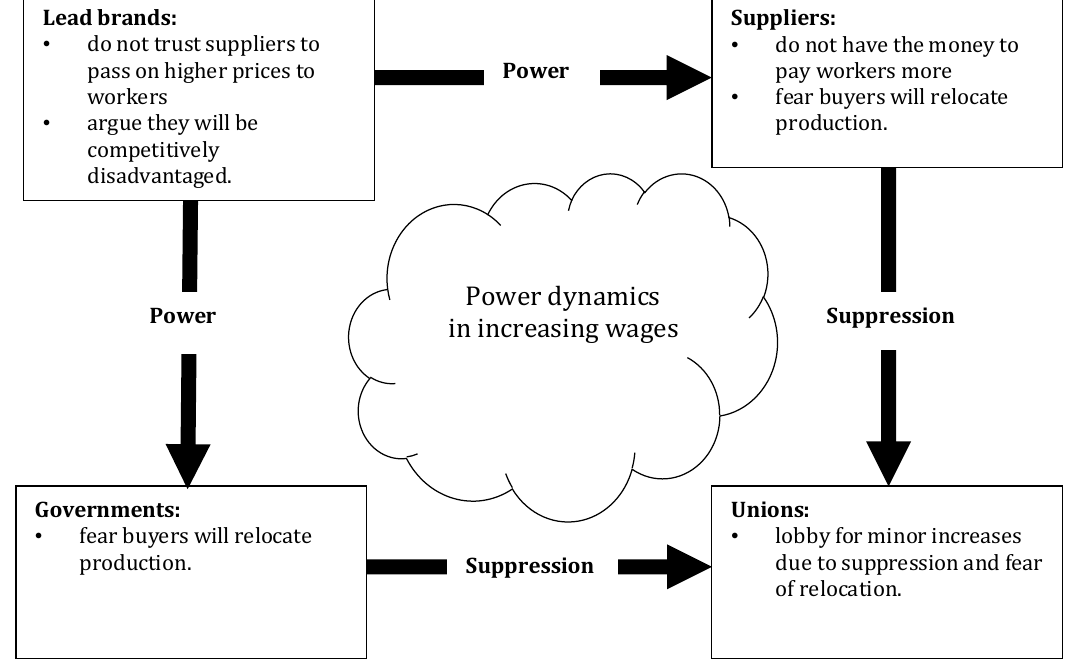
Figure 2. Power dynamics in global value chains (created by the